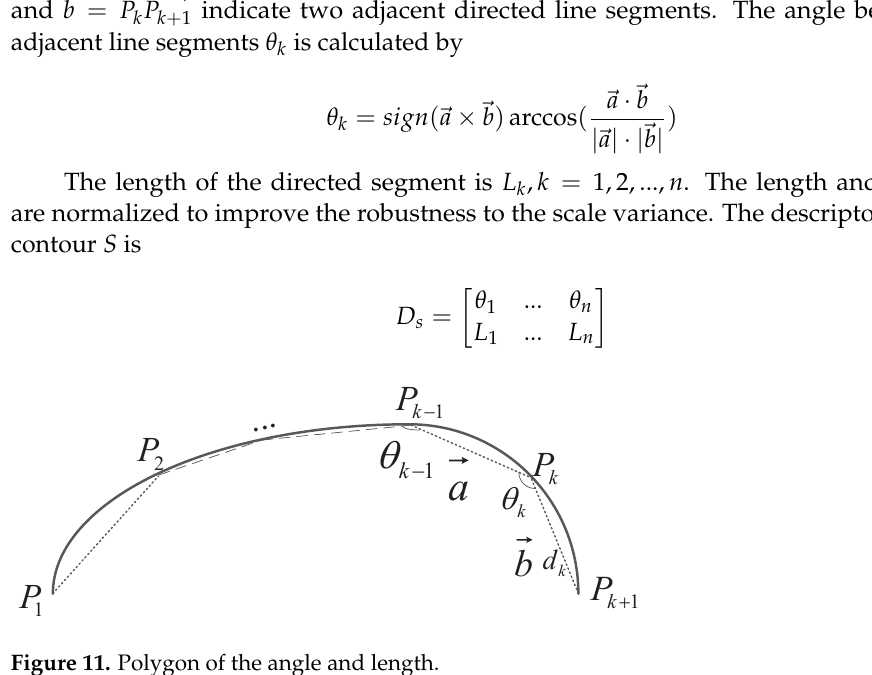
Figure 11. Polygon of the angle and